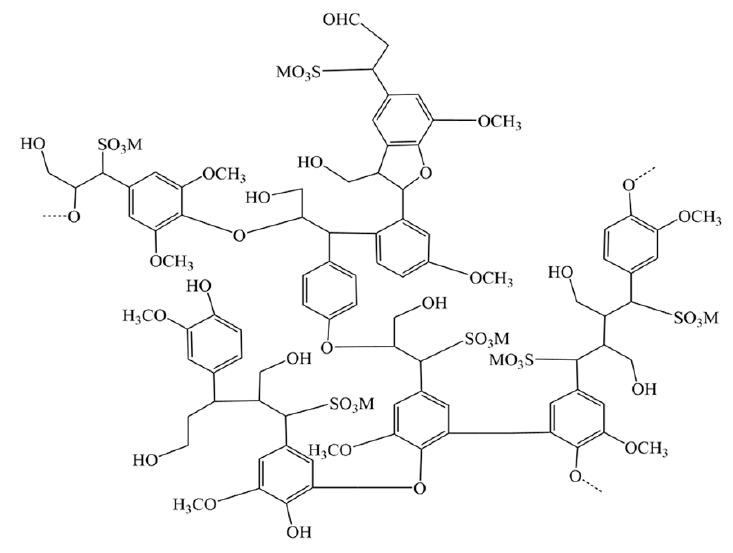
Figure 5. The structure model for lignosulfonates [86].